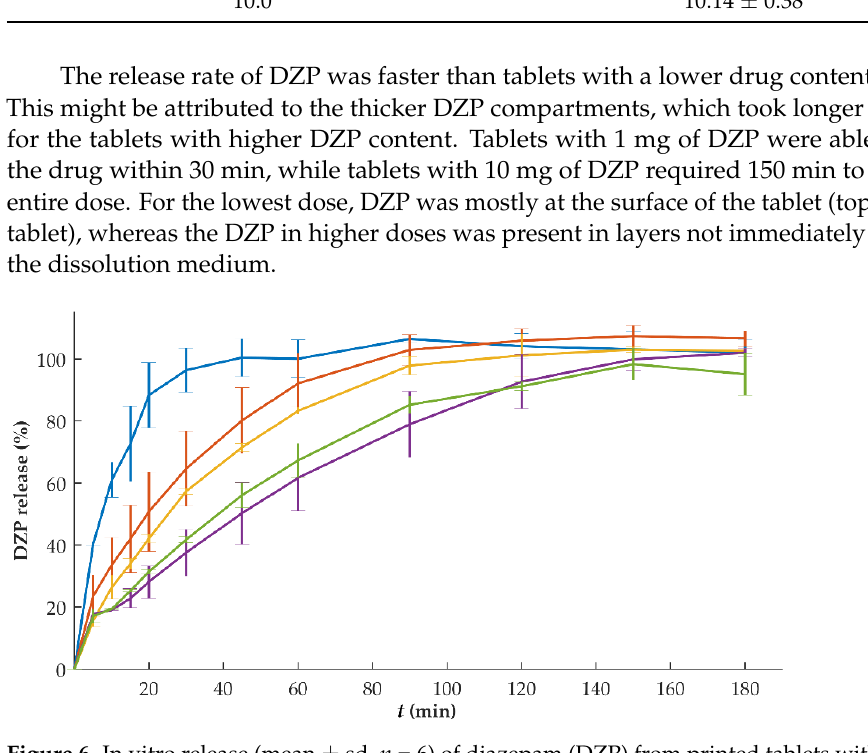
Figure 6. In vitro release (mean ± sd, n = 6) of diazepam (DZP) from printed tablets with a dose of 1 (blue), 2 (orange), 5 (yellow), 7.5 (purple) and 10 (green) mg.